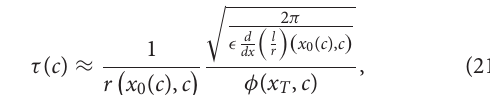
TABLE 2 | Parameters of the HA’s change of conformation model. Parameters Description